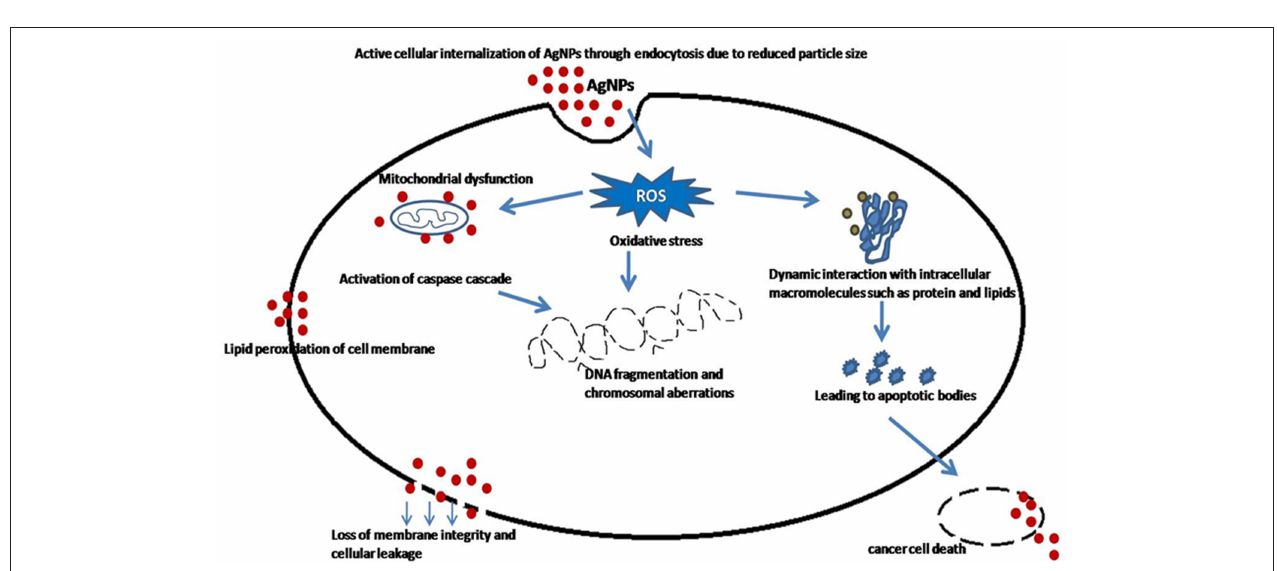
FIGURE 8 | Mechanism involved during